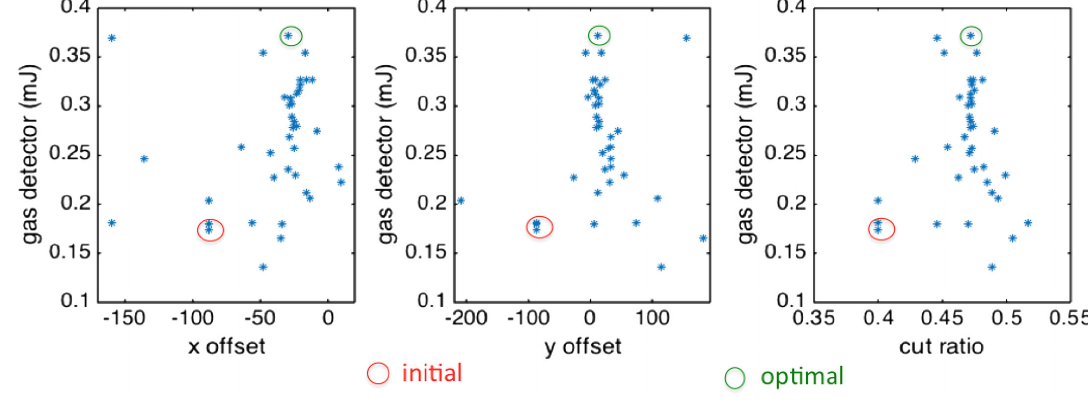
FIG. 6. The evolution of the FEL gas detector reading as a function of each of the